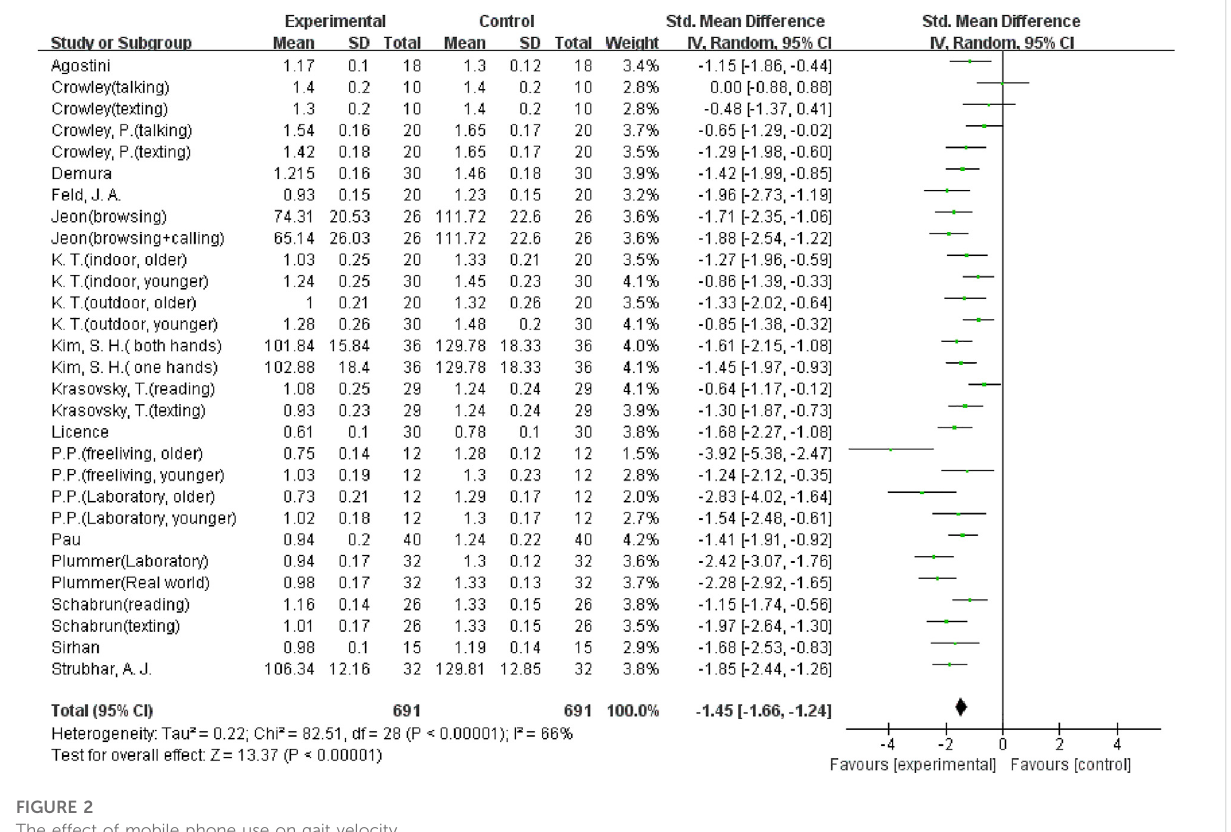
FIGURE 2 The effect of mobile phone use on gait velocity.